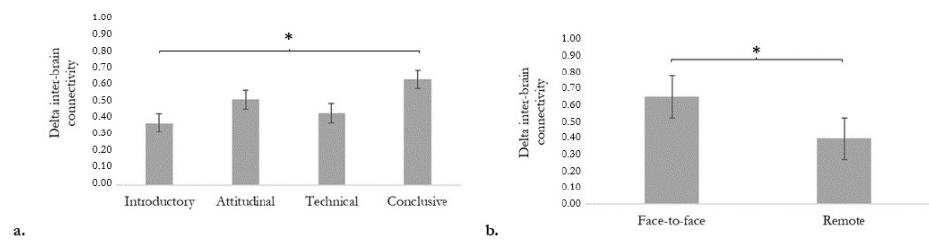
Figure 3. Theta intra-brain connectivity results ( a ) Bar graph shows differences in Condition (ROI). Bars represent ± 1 SE. Stars mark statistically significant pairwise comparisons. ( b ) Bar graph shows differences considering Condition*ROI. Bars represent ± 1 SE. Stars mark statistically significant pairwise comparisons. ( c ) Bar graph shows differences considering the interaction Interview*ROI*Role. Here are reported only candidate’s data where significant differences were detected. Bars represent ± 1 SE. Stars mark statistically significant pairwise comparisons.